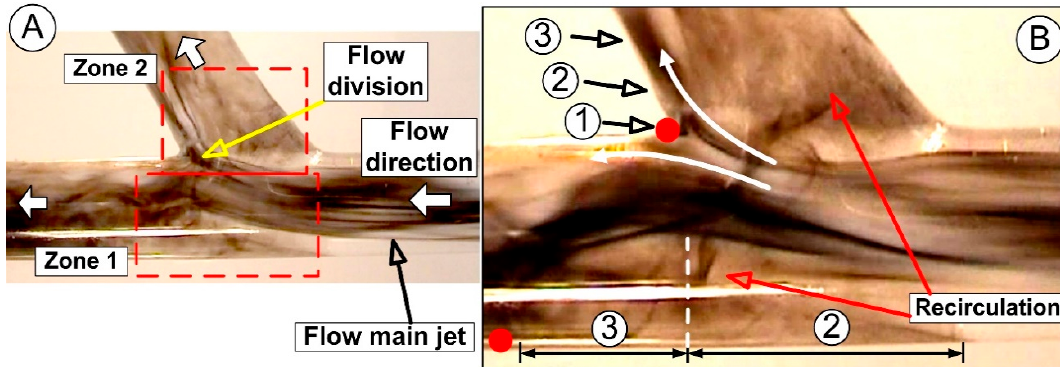
Figure 11. ( A ) The abnormal flow field is characterized by the flow division, strong flow impact around the apex, and flow oscillation on the host artery floor. The complex vortex structures created in the bifurcation area depend on the incoming flow structure; ( B ) detail of the flow bifurcation. Identification of the flow characteristic in the apex region: (1) impingement region, (2) acceleration region, (3) recovery region, and in the host artery floor: (2) acceleration zone and (3) deceleration (recovery) zone.